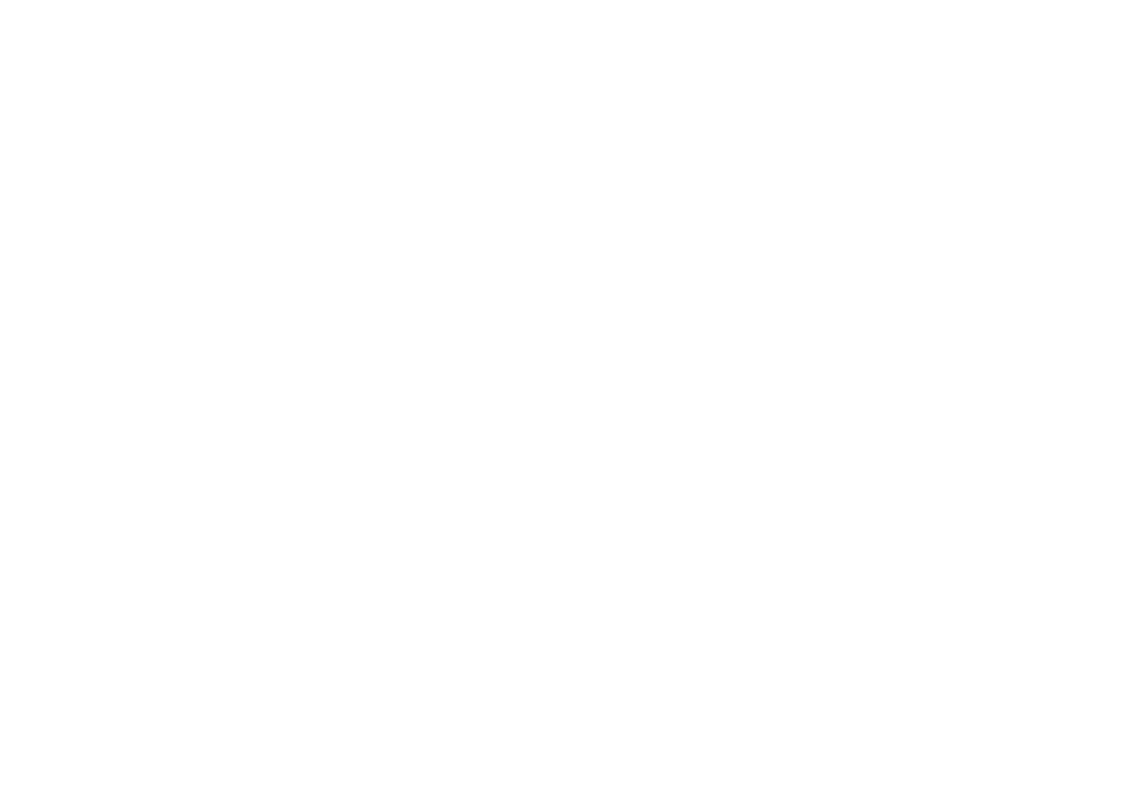
Frontiers in Psychiatry |